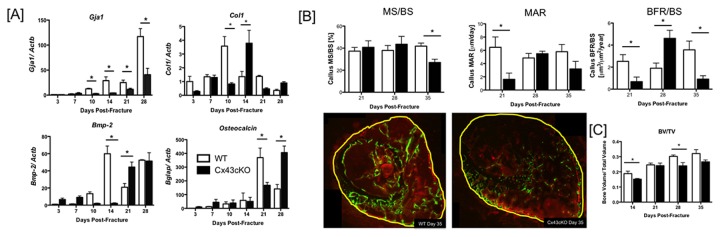
Delayed osteoblast maturation and bone formation in Cx43cKO fractures.[A] Expression of Gja1, Col1a1, osteocalcin and Bmp2 in the fracture callus of WT and Cx43cKO mice between 3 and 28 days post-fracture. RNA was extracted from the fracture callus and pooled from 3 specimens/ genotype/ time-point. (*) indicates p<0.05 between genotypes at a given time-point. [B] Dynamic histomorphometry analysis of WT and Cx43cKO fractures between 14-35 days. Specimens were labeled with Calcein and Alizarin Red, with a 7-day labeling period and Mineral Apposition Rate (MAR), Bone Formation Rate (BFR/BS) and Mineralizing surface/ bone surface (MS/BS) were calculated. (*) indicates p<0.05, N=3-5 specimens/ genotype/ time-point. Representative images of WT and Cx43cKO fractures labeled with Calcein (green) and Alizarin Red (red) and harvested at day 35 post-fracture. Yellow line corresponds to the perimeter of the callus. [C] Bone volume/ total volume (BV/TV) of WT and Cx43cKO fractures between 14-35 days. (*) indicates p<0.05 between WT and Cx43cKO fractures at a given time-point.